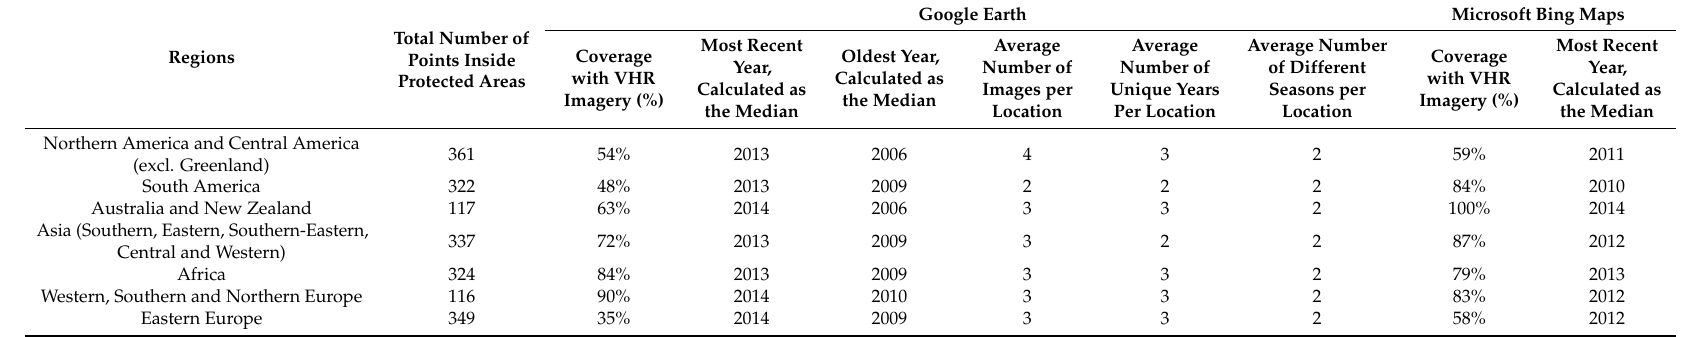
Table 3. Availability of VHR imagery (<5 m) inside protected areas grouped by